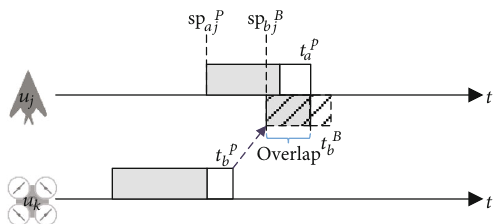
Figure 5: The relationship between start preparation times of overlapping tasks.